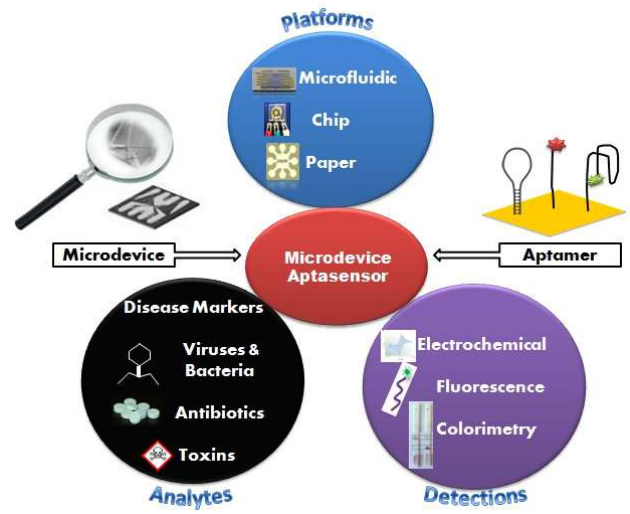
Figure 1. Schematic illustration of microdevice-based aptamer sensor with various platforms, detection methods and application to actual samples.